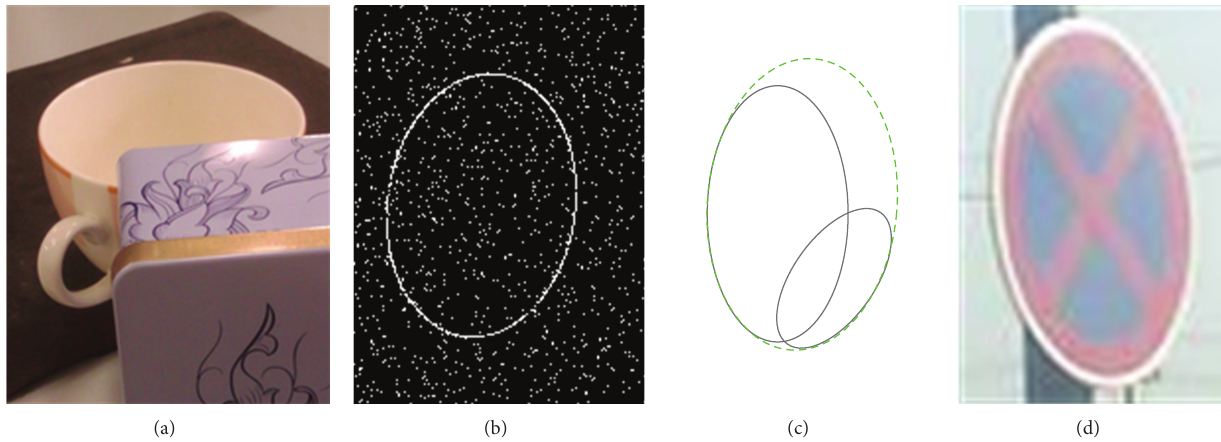
Figure 1: Major difficulties of ellipse detection. (a) Ellipse at the cup mouth is blocked partially. (b) Noise interrupts the elliptical curve or generates fake branches. (c) Outlier causes incorrect detection, where the black ellipses are true ones and the green dashed ellipse is the incorrect detection result. (d) Low resolution makes the ellipse curves